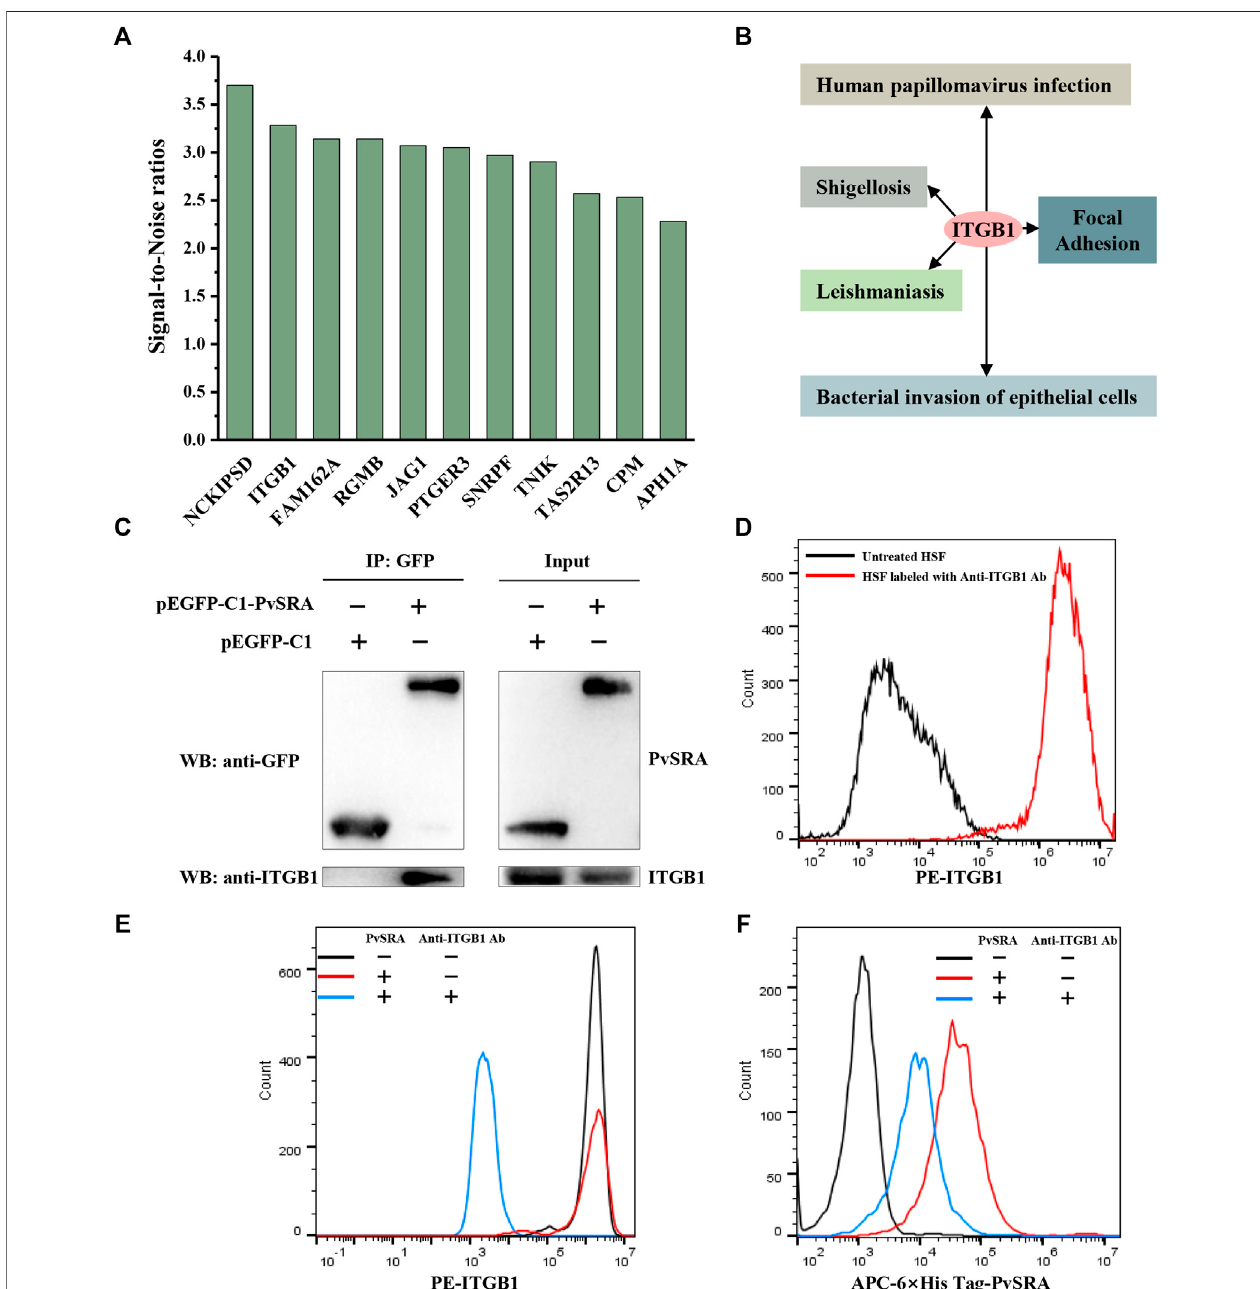
FIGURE5| ITGB1locatedonHSFcellsurfaceisareceptorforPvSRA. (A) HistogramofthePvSRAsubstratesoncellmembranesurface.SNR,thesignal-to-noise ratio. (B) KEGG analysis demonstrated that ITGB1 is involved in several pathways with a p value < 0.05. (C) Interaction between PvSRA and ITGB1 was veri fi ed by Co- immunoprecipitation testing. ITGB1 is expressed by HEK293 cells, pEGFP- C1- PvRSA was transfected into the HEK293 cells with Lipofectamine 3000, while pEGFP- C1wasusedasnegativecontrol. (D) FACSanalysiswasperformedtoverifyITGB1expressiononHSFcellsurface. (E,F) Backwardveri fi cationwasappliedtoverify whetherITGB1isareceptorofPvSRAthroughblockingITGB1functiononHSFsurfacewithanti-ITGB1antibody.Anti-6 × Histagantibodyandanti-ITGB1antibodywere used to reveal PvSRA and ITGB1 proteins, respectively.